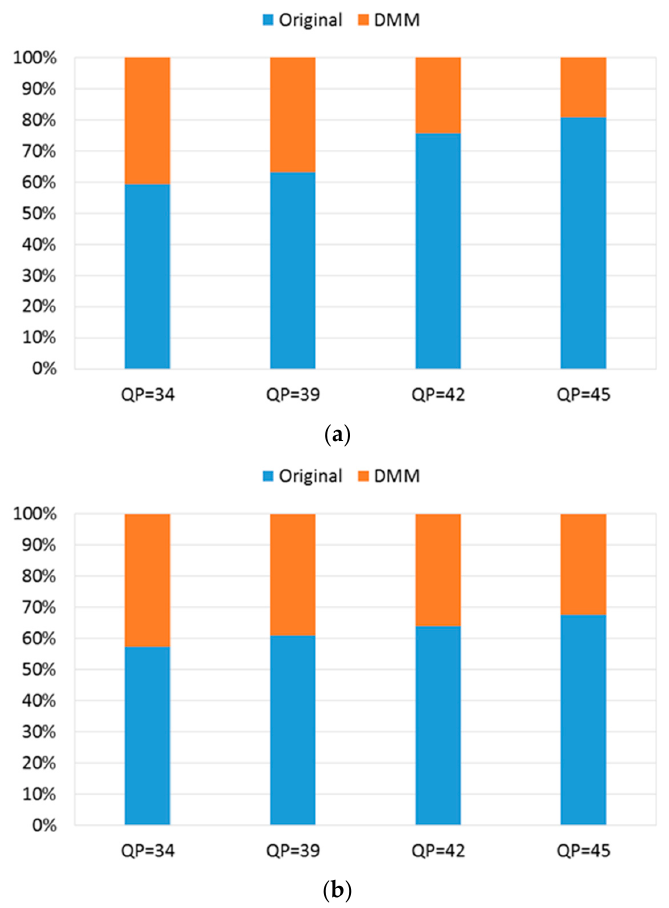
Figure 4. Mode decision runtime of the original and DMM-related mode decision processes in ( a ) Poznan_Hall2 and ( b ) Kendo test sequences with quantization parameters (QPs) of 34, 39, 42, and 45.